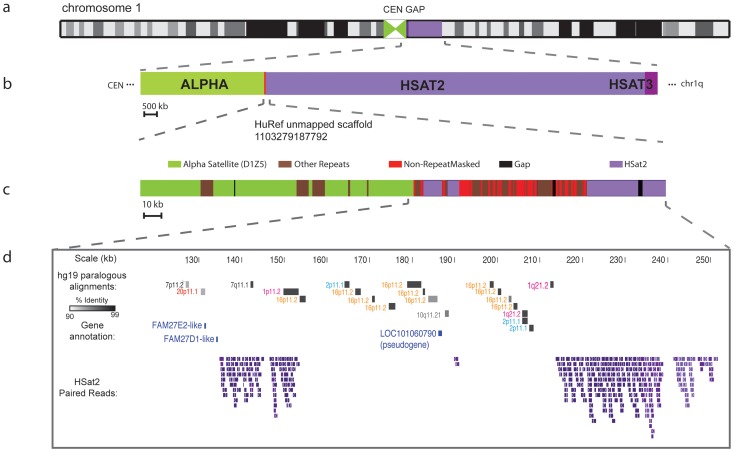
Unmapped scaffold uniquely mapped to HSat2-rich region on chromosome 1.This unmapped scaffold (HuRef SCAF_1103279187792) defines an inter-satellite region in the large centromeric/heterochromatin gap on chromosome 1 (a), which is located between alpha satellite (centromeric region) and Human Satellites 2,3 (heterochromatic gap) (b). It contains roughly 60kb of non-RepeatMasked sequence (c), most of which represents ancient segmental duplications to the pericentromeric regions of chromosomes 1, 2, 7, 10, 16, and 20. Also shown are the positions of annotated gene predictions and HSat2-containing reads used in the assembly of this scaffold (d).